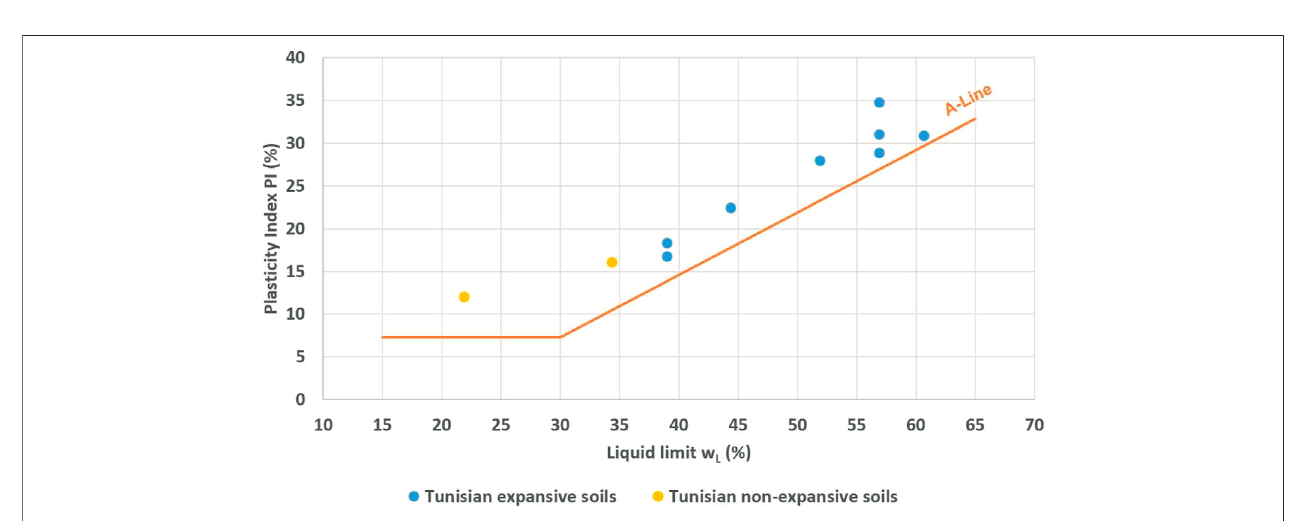
FIGURE 6 | Casagrande ’ s plasticity